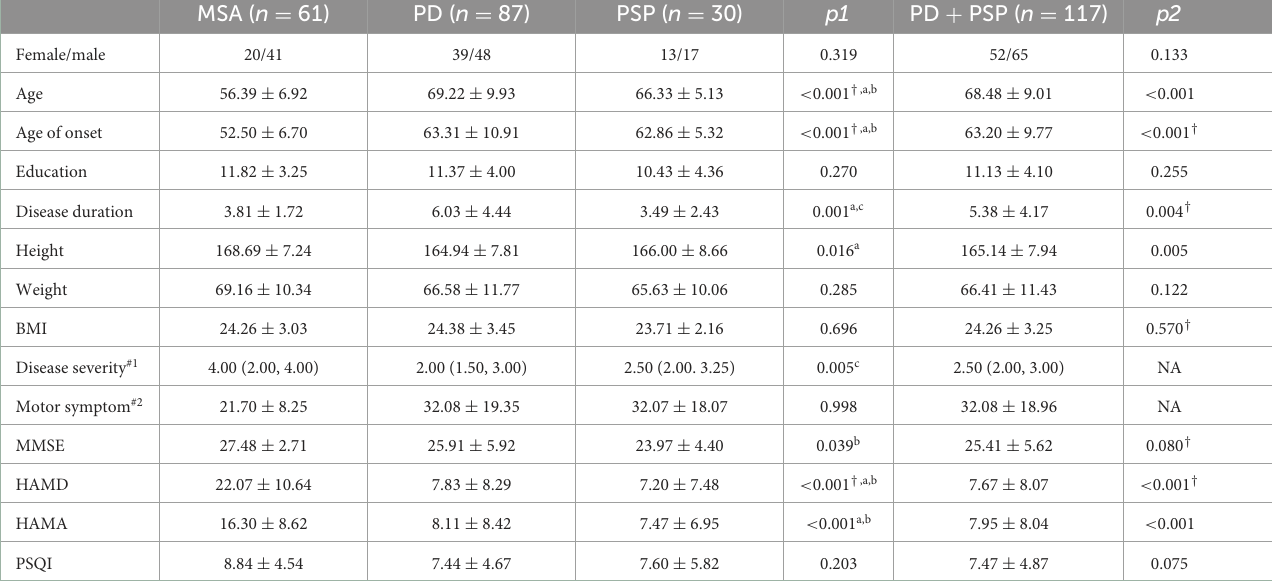
TABLE 1 Demographic and clinical data of MSA vs. PD and